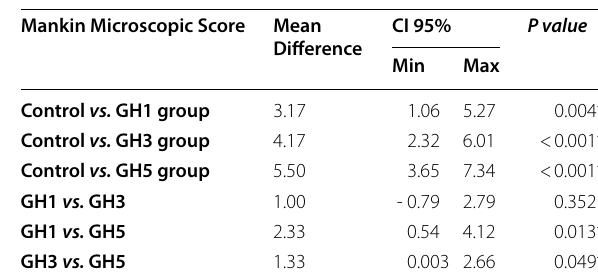
Table 4 Statistical analysis and comparison of Mankin score between